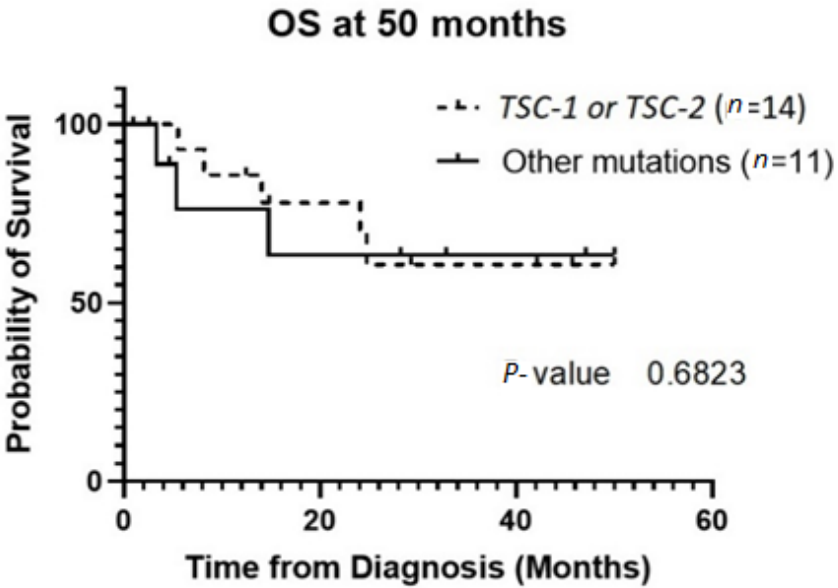
Figure 2. OS of the group of patients with TSC-1 and -2 mutated tumors versus other mutations. Patients who did not have genetic testing sent out were excluded from this analysis. Abbreviations: OS, overall survival; TSC, tuberous sclerosis complex.